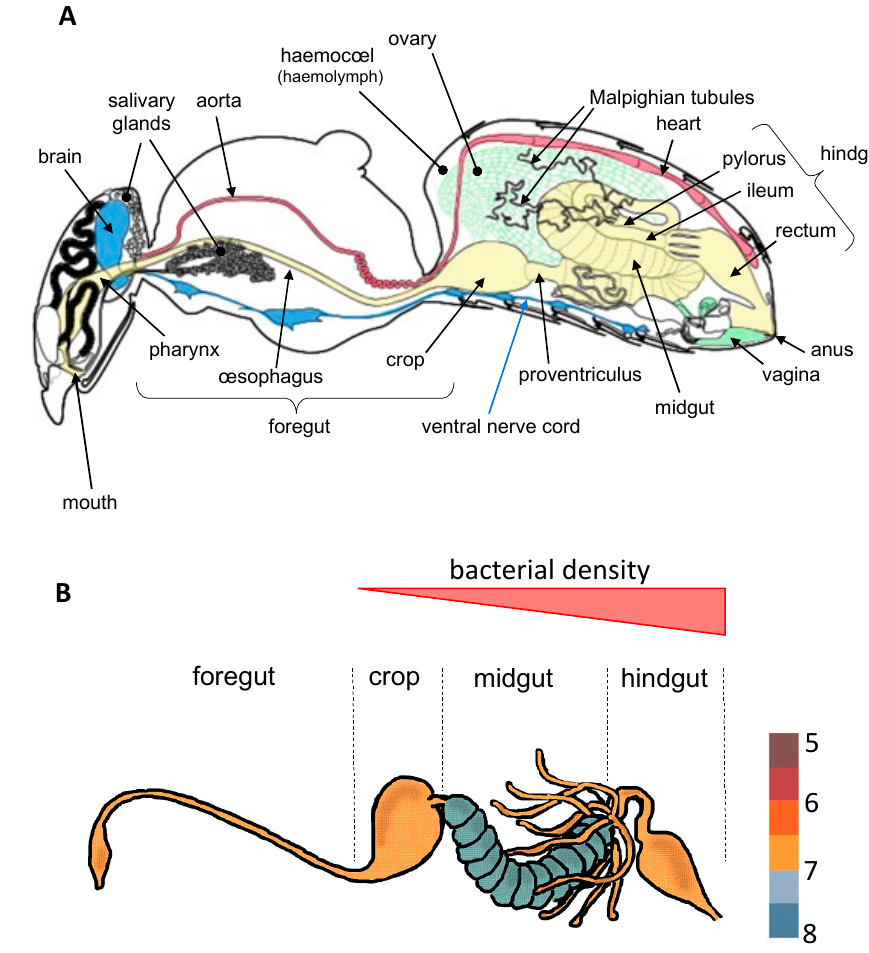
Figure 1. The internal anatomy of an insect ( A ) and variability of bacterial density across the digestive tract ( B ), taking the bee as example (according to Tofilski A.; http://honeybee.drawwing.org, accessed on 5 March 2021 and Kešnerová et al. [14]). All insects present an internal cavity (the hemocoel) containing a circulatory fluid (hemolymph) and all organs forming the digestive (in yellow), reproductive (in green), circulatory (in red), respiratory or nervous (in blue) systems. Insect bacterial microbiota offer a wide range of benefits to their host, ranging from increased fecundity [15], oviposition [16], and longevity [17] to shorter larval development